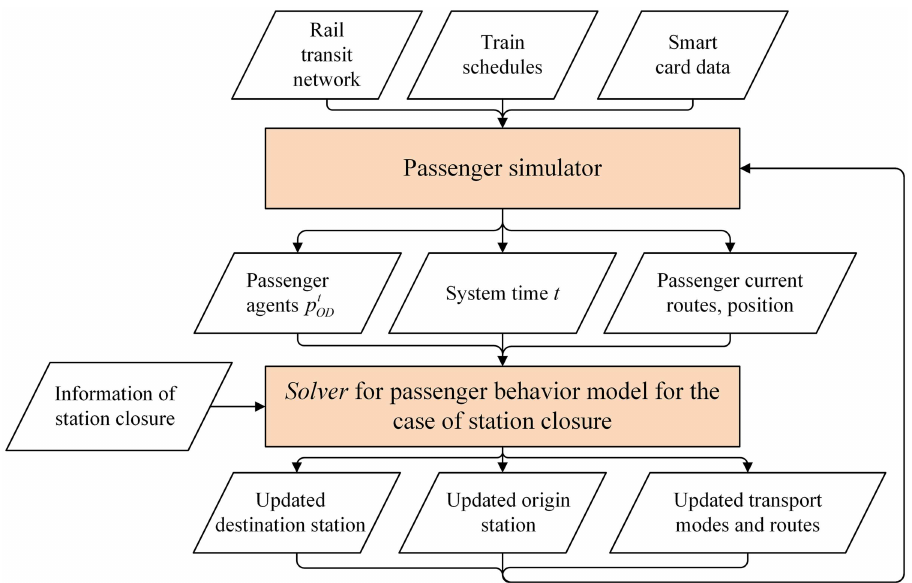
Fig 4. The frameworkof the integrated solution algorithm. There are two core modulesin the solution algorithm: the passengersimulatorand the model solver. The main inputs of the passengersimulator are the rail transit network, train schedules, smart card data, and bus/taxi data. In addition,the simulator provides instant passengerinformation, including the current path, station, and train, for the tens of thousandsof behavior optimizationmodels. The closuredurationand its overestimation are also the inputs of the model solver. Finally, the outputs of the model solver, namely, the updateddestinationstation, origin station, the transport mode and paths, are computedand then become the inputs of the